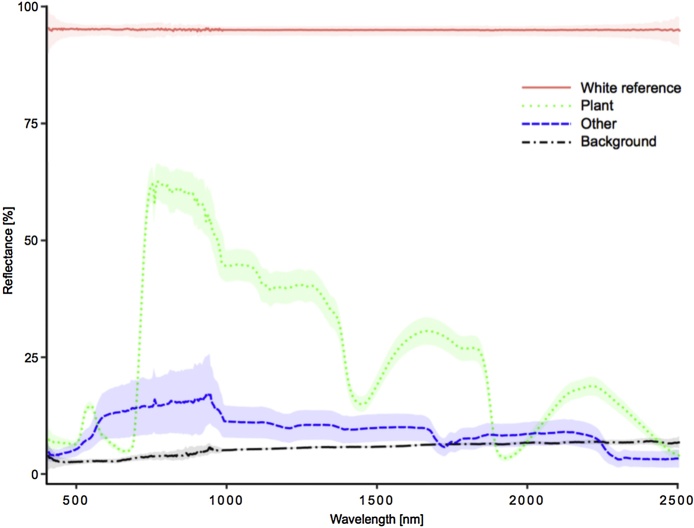
Spectral signatures of the four classes included in the spectral libraries. Lines denote mean spectra, and ribbons their according standard deviations.